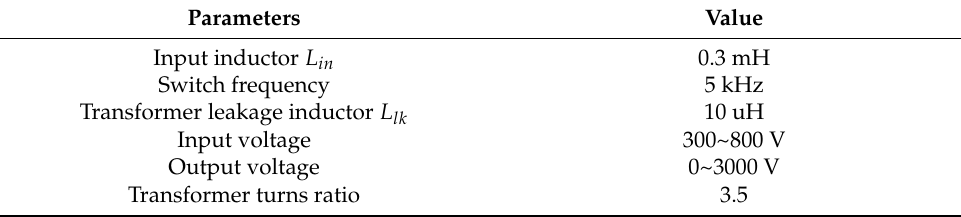
Figure 14. 3 kV/80 kW DC–DC module with reconfigurable topology. Table 2. Parameters of the DC